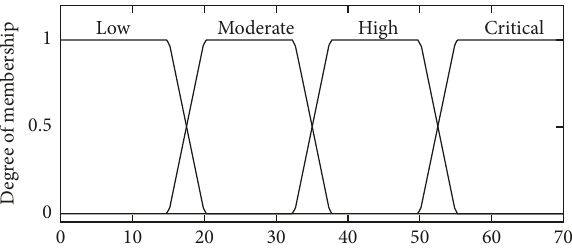
Figure 7: Input variable membership function-DGA Factor